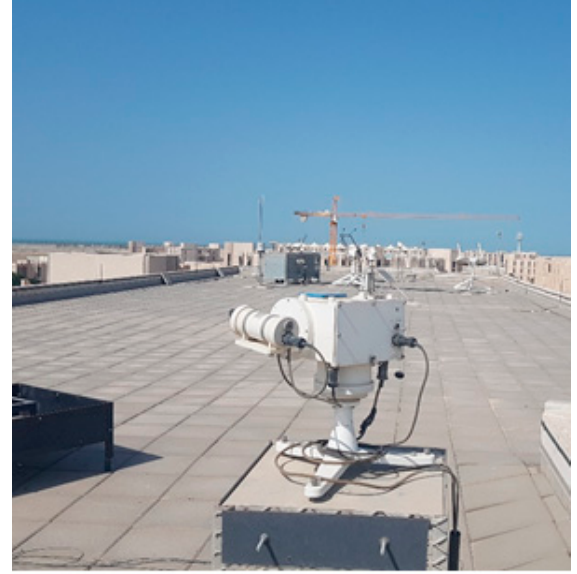
Figure 3. The sky scanner, on the roof of the College of Architecture and Planning, Imam